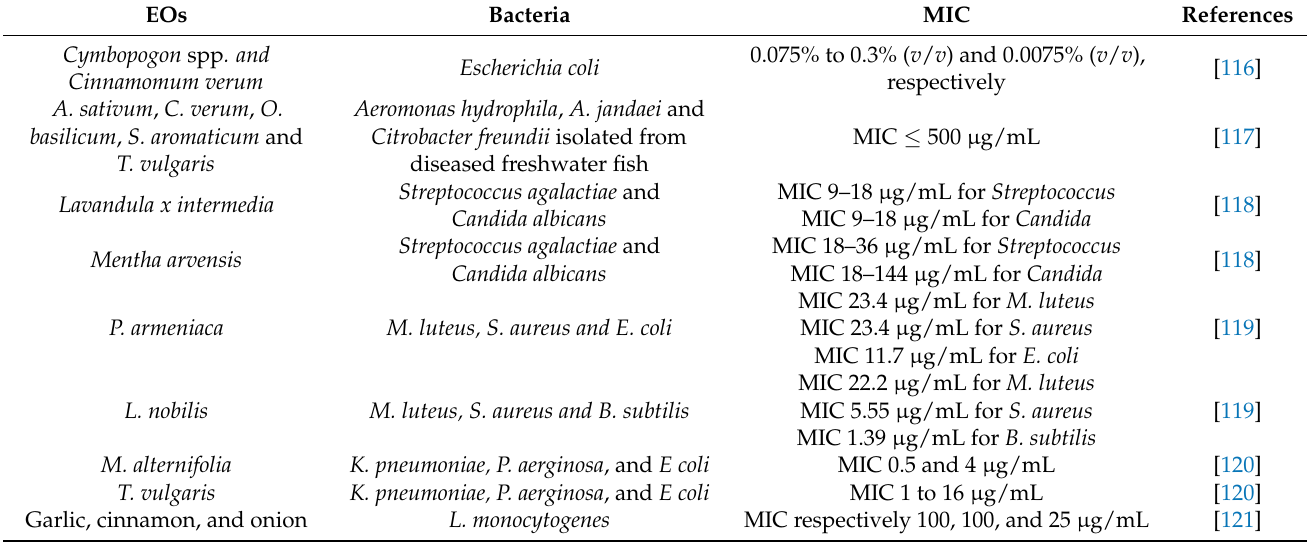
Table 2. List of recent studies that tested the antibacterial properties of some EOs against pathogens by identifying the minimum inhibitory concentration (MIC) of